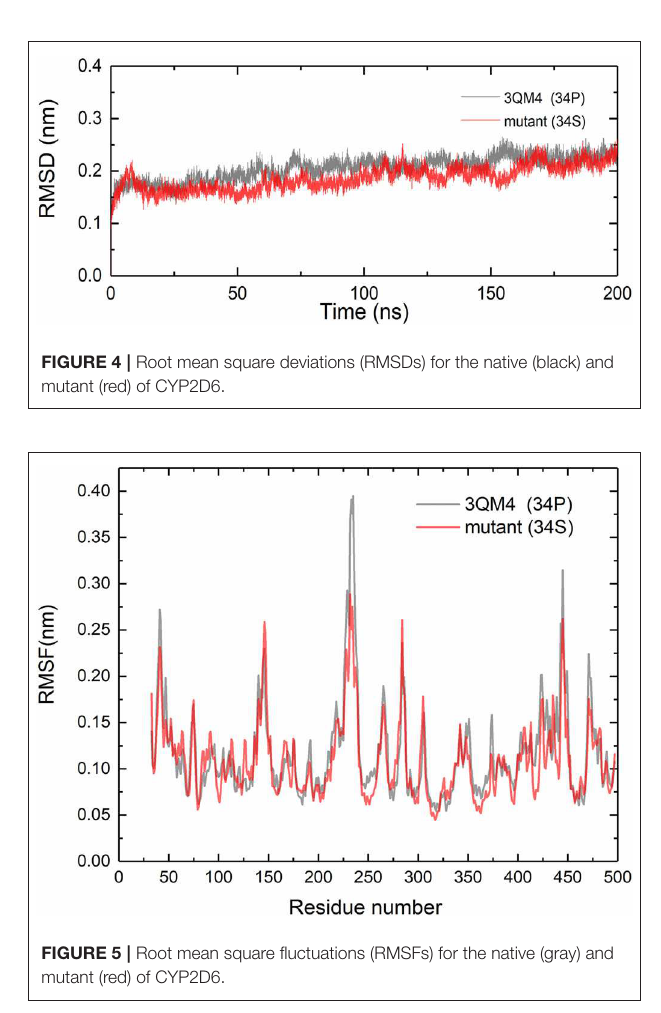
acid properties, the serine is smaller than the native